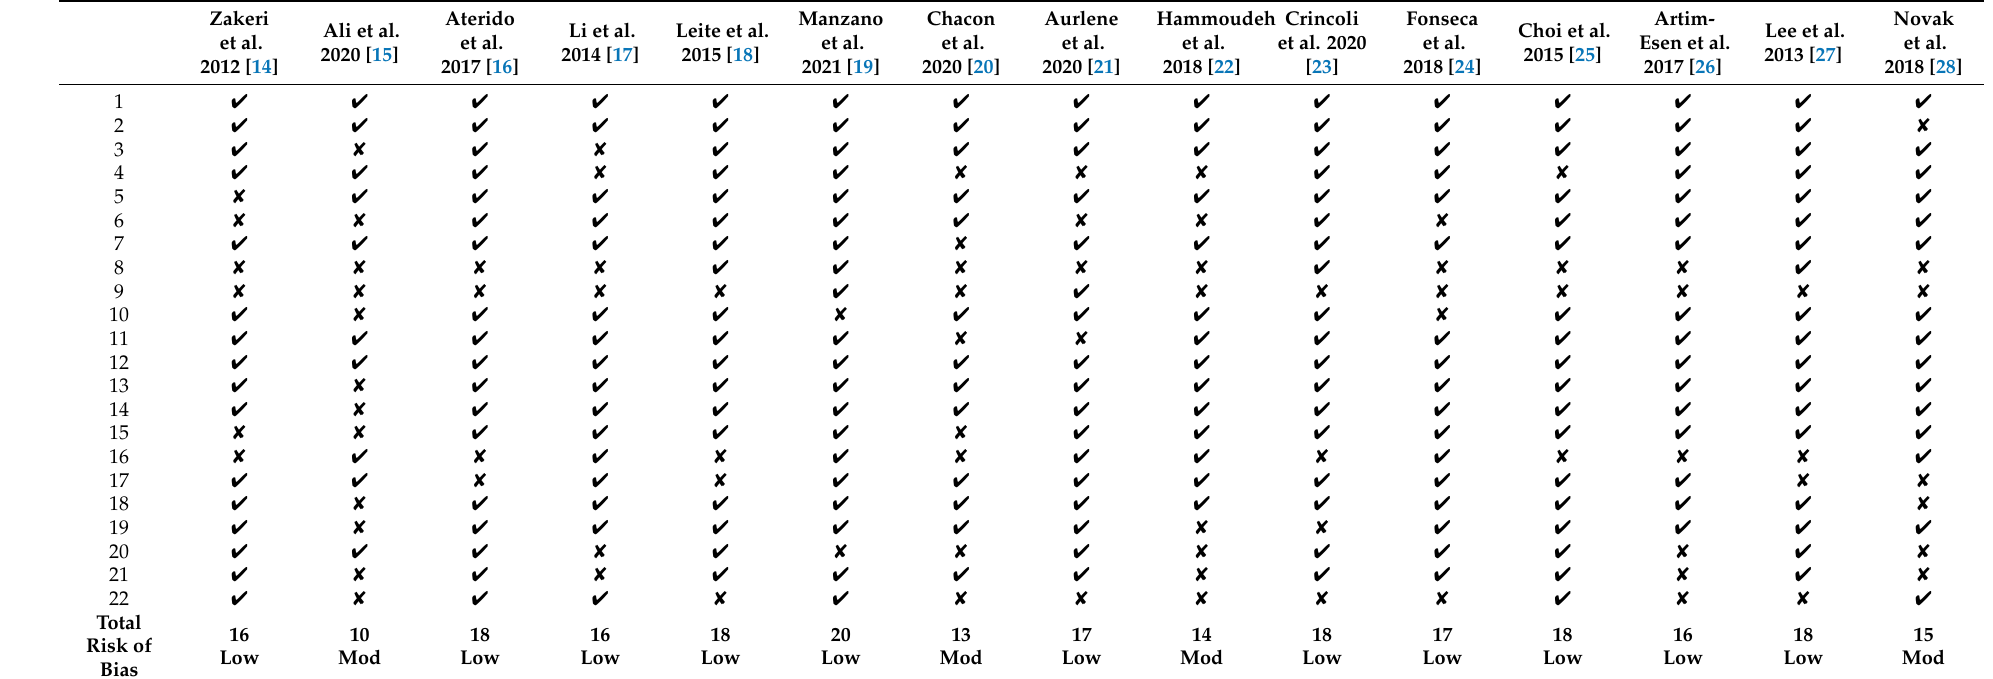
Table 4. Quality analysis